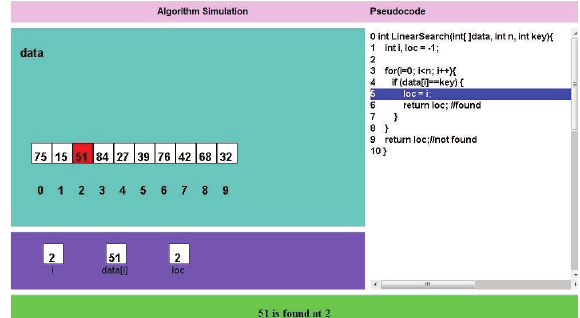
Figure 5: Algorithm simulation field, pseudocode display, variable, and message fields for